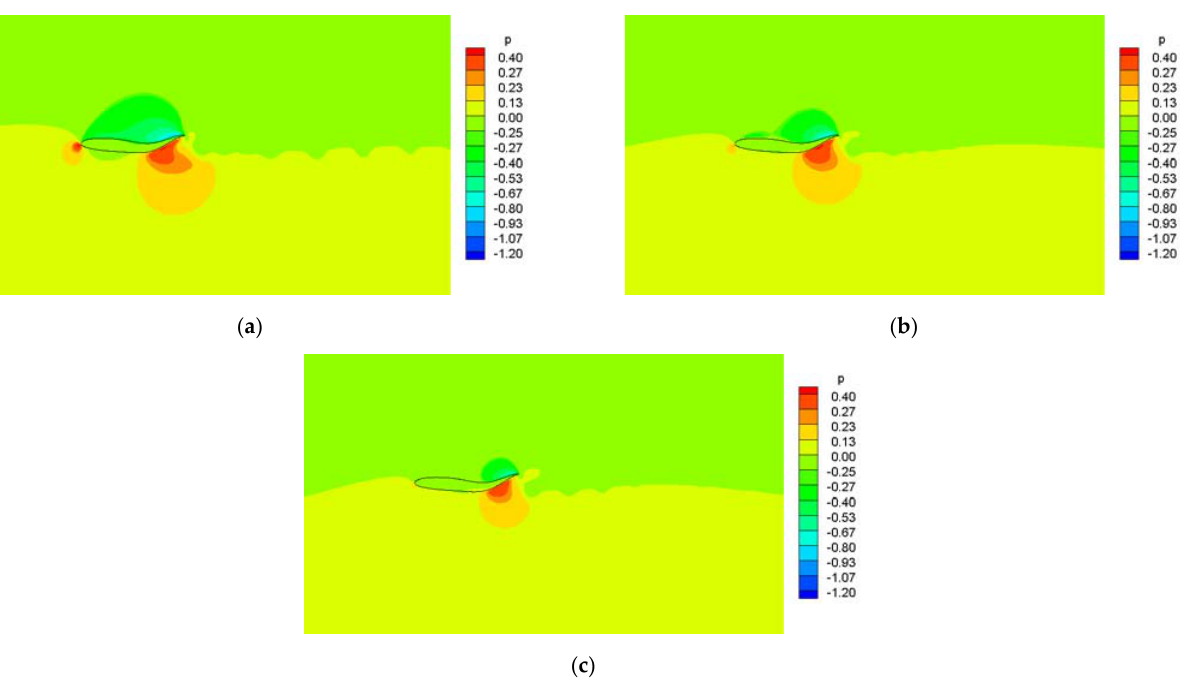
Figure 11. Pressure contours at different Reynolds numbers. ( a ) 𝑅𝑒 (cid:3404) 5000 ; ( b ) 𝑅𝑒 (cid:3404) 50,000 ; ( c ) 𝑅𝑒 (cid:3404) 500,000 .